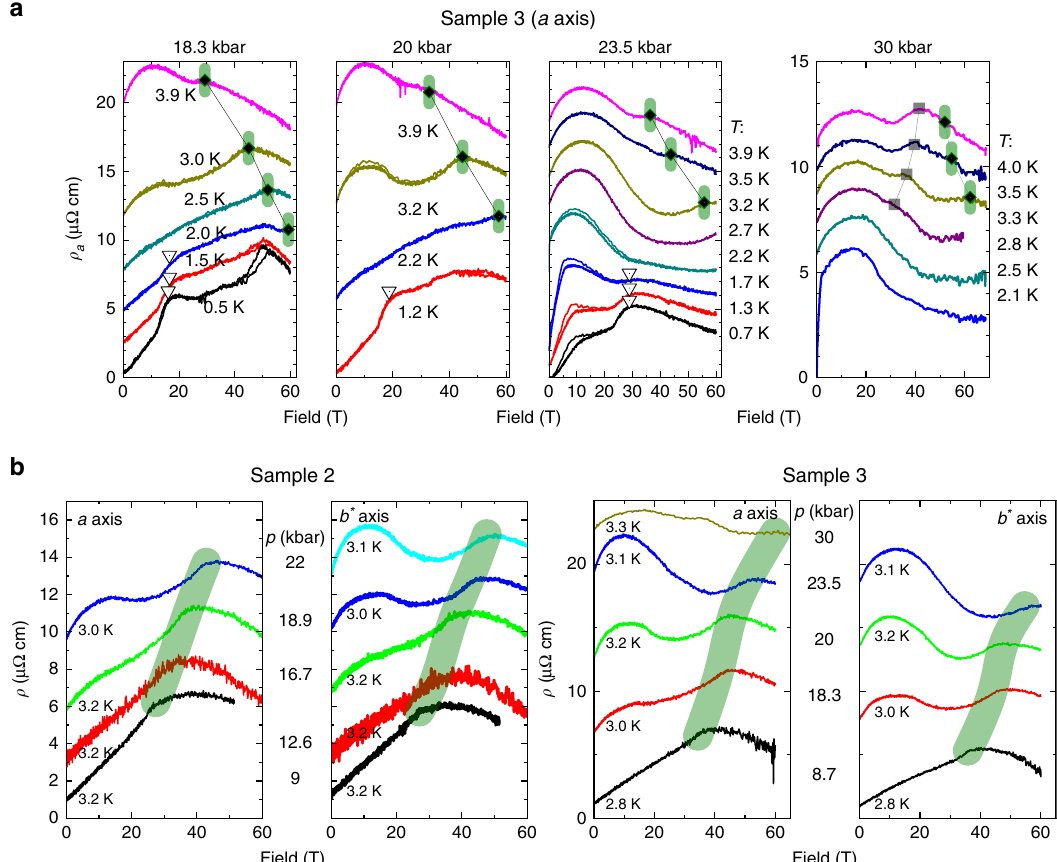
Fig. 5 Temperature-dependent signatures of magnetic order. a MR for sample 3 recorded at various temperatures and p = 18.3, 20, 23.5, and 30 kbar. The green shaded region marks the AFM suppression fi eld B c (for a detailed comparison of samples 2 and 3 see Supplementary Fig. 5). Black squares and hollow triangles mark the onset fi eld B c,low and the metamagnetic transition fi eld B M (see main text). b Isothermal MR for samples 2 and 3, respectively, for different pressures at temperatures close to 3 K. This allows to directly trace the evolution of the break in slope that is known from zero-pressure measurements to correspond to B c ( p = 0, T ). Left and right panels exhibit the I ∣∣ a - and I ∣∣ b * -direction, respectively. The curves are vertically offset for better visibility.